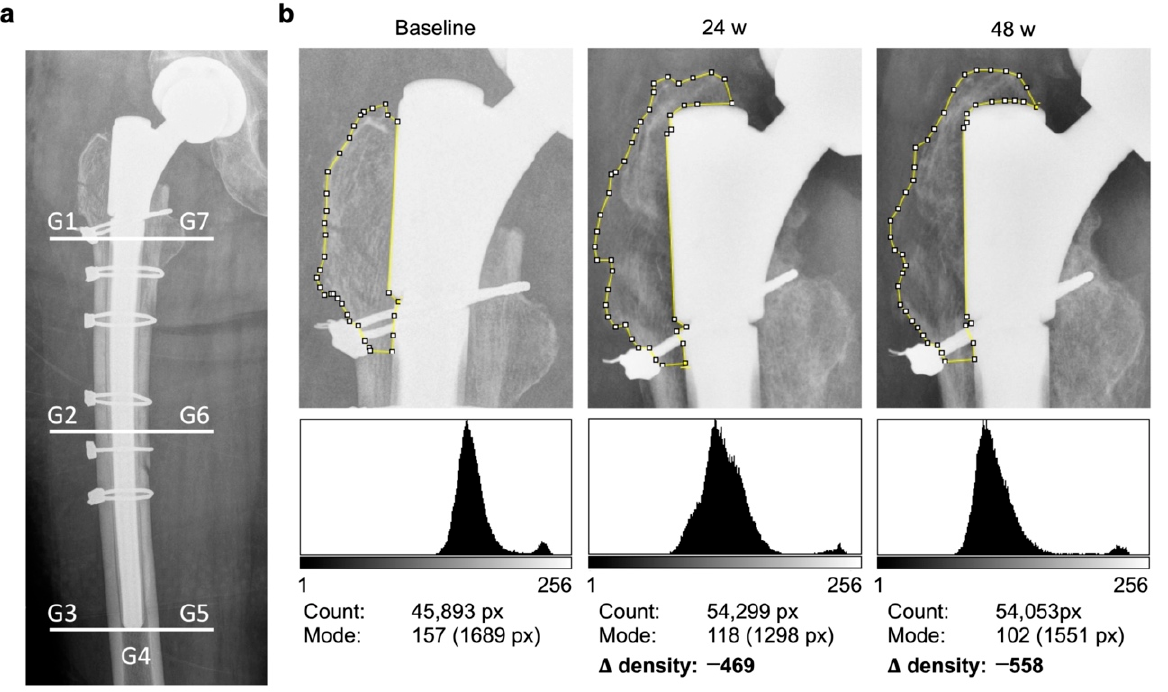
Figure 1. Workflow of the semi-quantitative relative bone density measurement method using ImageJ involving ( a ) the subdivision into seven periprosthetic Gruen zones (G). ( b ) Example case of proven bone density loss in zone G1 after prosthesis revision due to periprosthetic fracture. After subdividing the proximal femur into the periprosthetic zones on a conventional AP pelvis standing radiograph, each region was individually tagged with the polygon tool as depicted for G1. ImageJ defined the total number of enclosed pixels (Count) and the measured modal gray values (Mode) together with the corresponding number of pixels as in the displayed histograms. Due to the modal value, external influences, such as the cerclage in this case, had no influence on the result. Then, the modal gray value was normalized with the results of the measurement of the high and low zones of each radiograph. The differences of these scores to the perioperative baseline objectively represented the remodeling of bone density as Δ -density and could thereby prove the decrease of bone density in G1 in the present case.